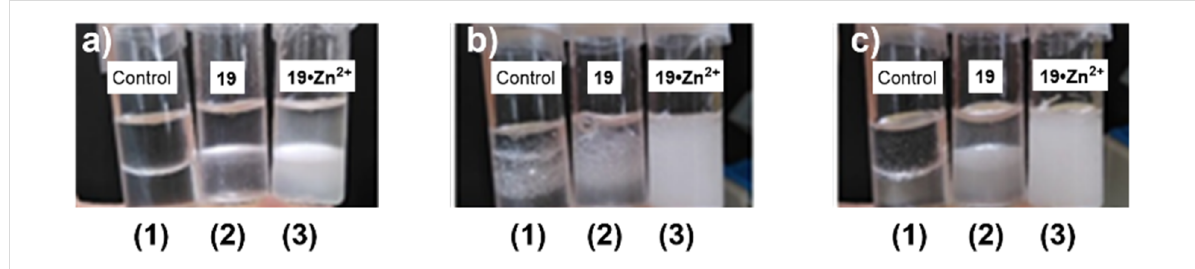
Figure 3: (1) 1:1 Mixture of 1-octanol/H 2 O, (2) same solvent mixture with compound 19 , and (3) same solvent mixture with compound 19 + 1.0 equiv Zn(OTf) 2 before agitation (a), just after agitation (b), and 50 s after agitation